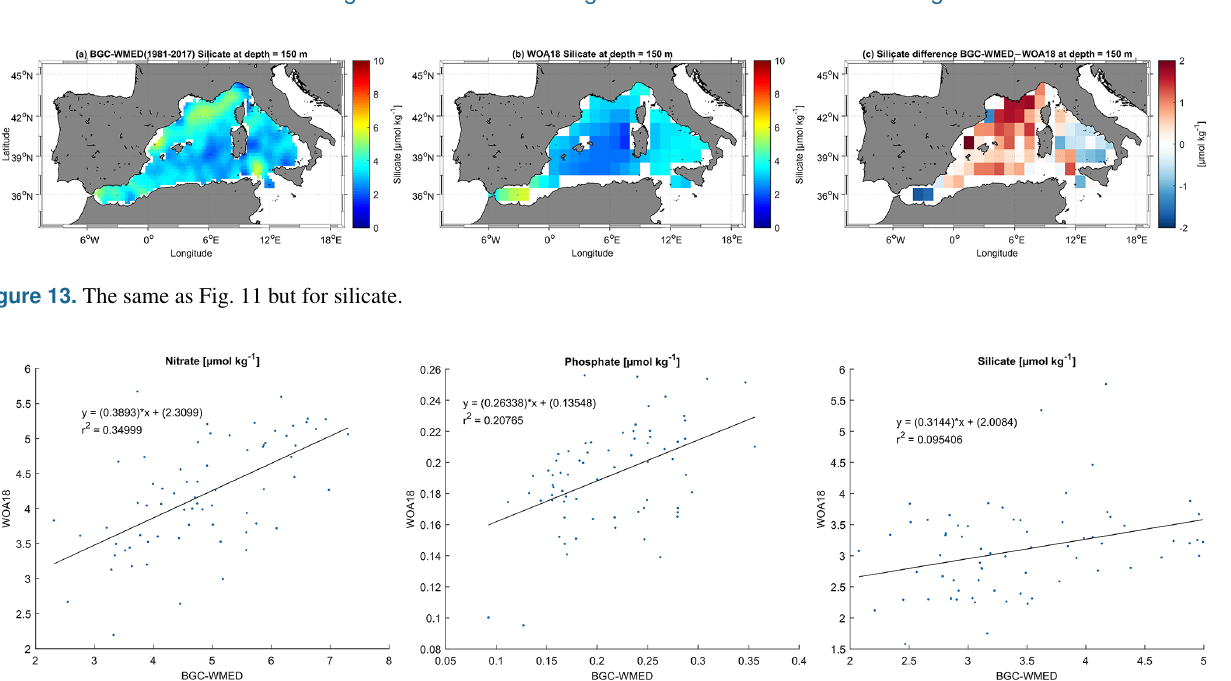
Figure 14. Scatterplot showing the WOA18 data as a function of the BGC-WMED at 150m with the regression line.